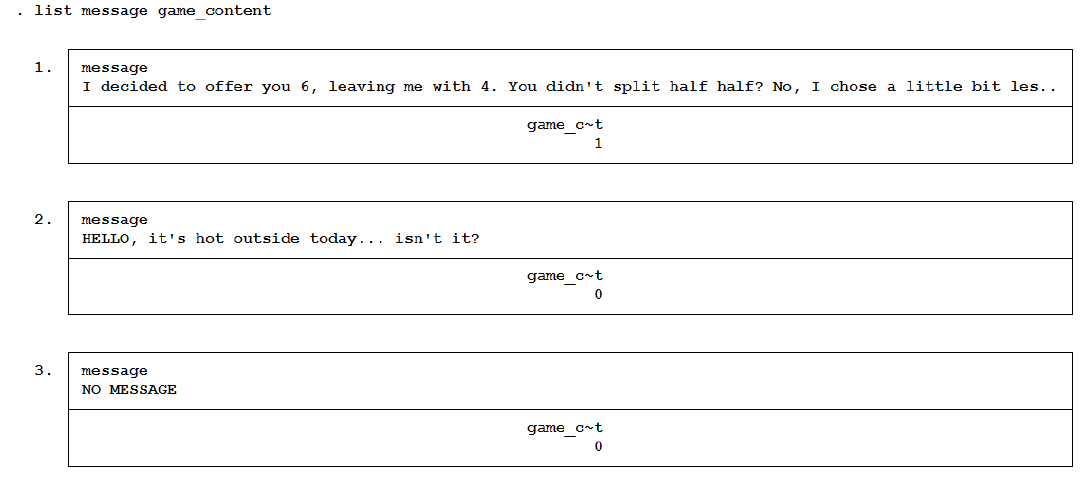
Figure A1. Stata output.